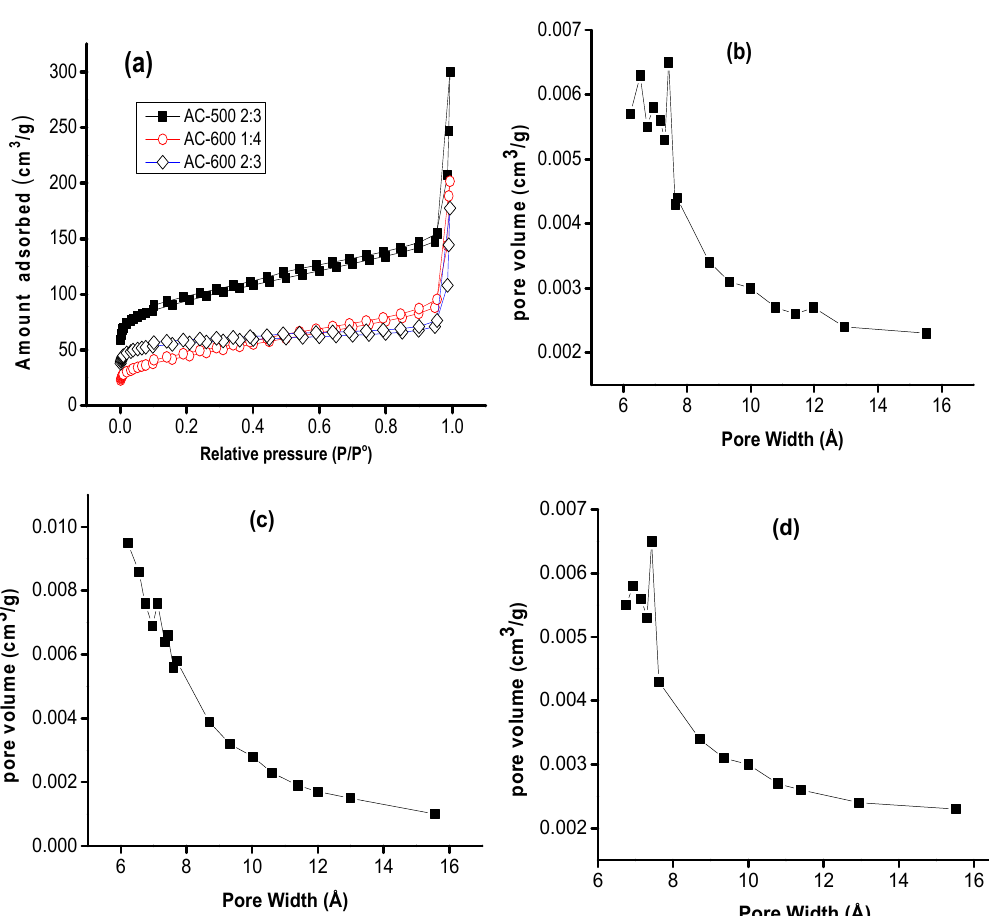
Figure 3. ( a ) Adsorption–desorption isotherms of N 2 and ( b ), ( c ), and ( d ) are the corresponding pore size distributions curves as obtained by the BJH method for AC-600 2:3, AC-600 1:4 and AC-500 2:3, respectively. Table 1. Surface area and porosity of activated carbon.